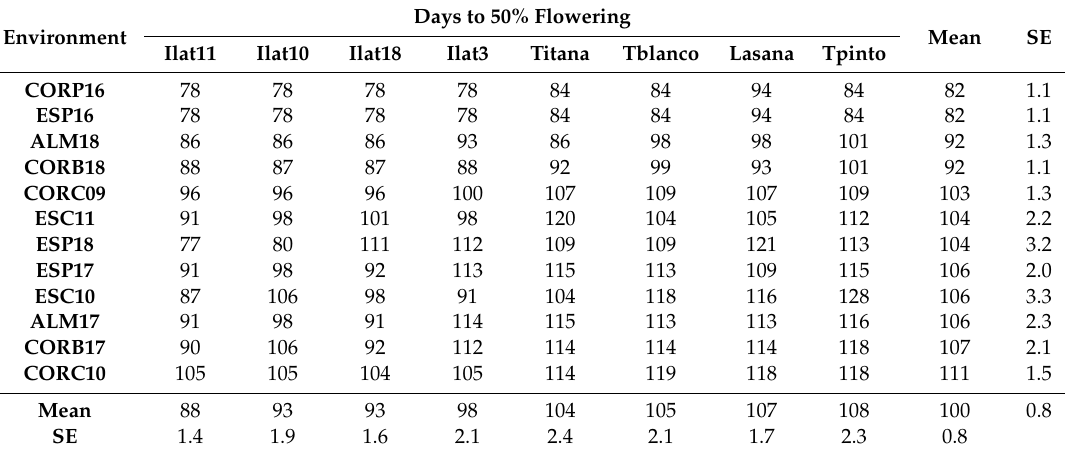
Table 5. Days to 50% flowering (DtF) in 12 environments (in increasing order).